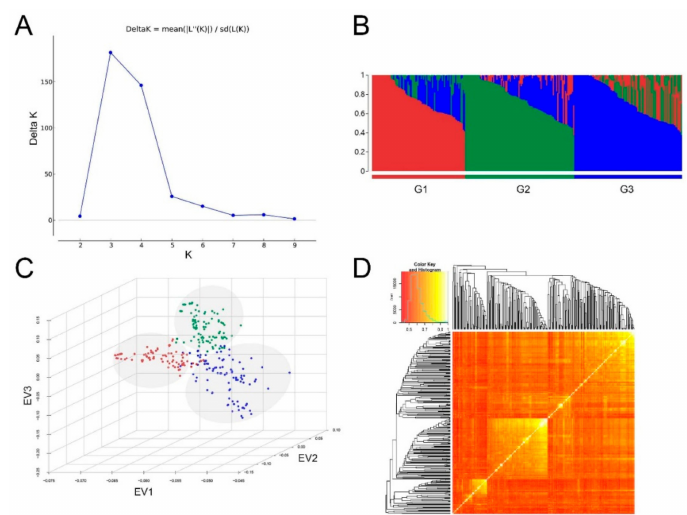
Figure 1. Population structure analysis of the soybean association panel using 8148 single nucleotide polymorphisim linkage disequilibrium blocks (SNPLDB) markers. ( A ) Estimation of the number of subpopulations using the STRUCTURE program. Delta K shows K = 3 as the most likely number of subpopulations. ( B ) Population structure bar plot at K = 3 inferred by the STRUCTURE program. Each bar represents one accession, and the bars are filled by colors representing the likelihood of membership to each subpopulation. G1 (red), G2 (green), and G3 (blue) denote three subpopulations. ( C ) Scatter plot of the top three eigenvectors (EV1, EV2, and EV3) with the largest eigenvalues of the genetic similarity coe ffi cient matrix based on SNPLDB markers, which were calculated by restricted two-stage multi-locus genome-wide association analysis (RTM − GWAS) software. Each dot in the scatterplot represents an accession. Accessions are colored according to the subpopulation they were assigned to by STRUCTURE at K = 3. ( D ) Heatmap of genetic similarity coe ffi cient matrix based on SNPLDB